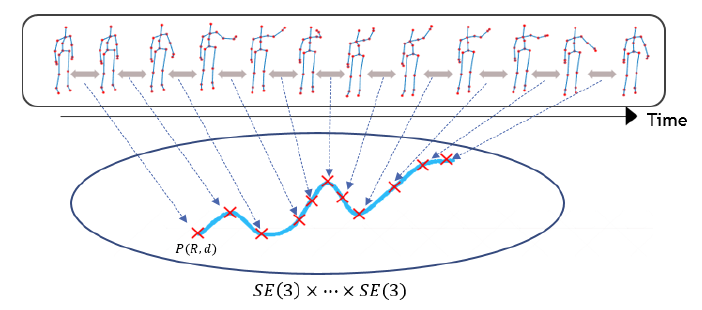
Figure 2. Action as a curve in the Lie